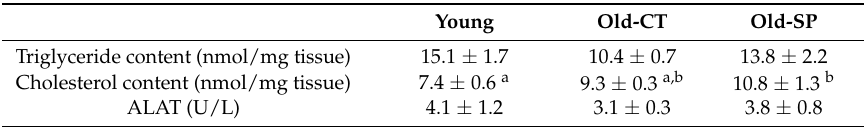
Figure 5. Expression of TLR2 ( A ) and TLR4 ( B ) in the ileum. Levels of TLR2 ( C ) and TLR4 ( D ) agonist activities in feces and in Spirulina, itself. Old mice were fed a standard diet supplemented with or without Spirulina for six weeks and were compared to young mice fed a standard diet. Data with different superscript letters are significantly different at p < 0.05 (ANOVA). TLR, toll like receptor. Table 2. Parameters related to liver lipid accumulation and hepatotoxicity.